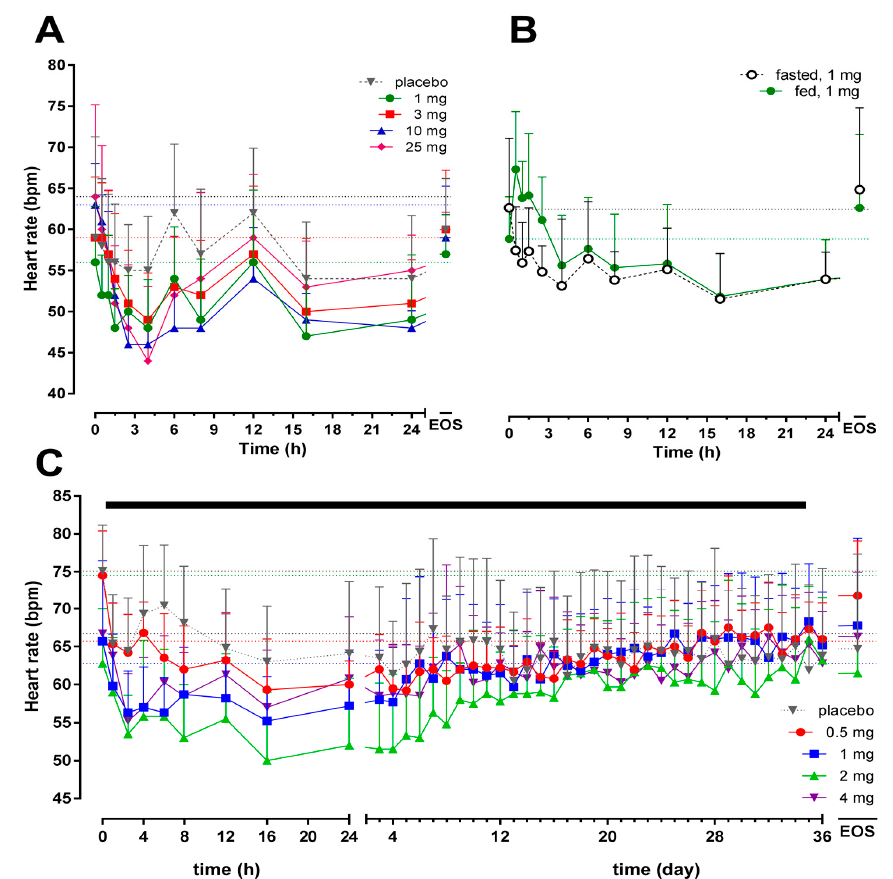
Figure 4. Arithmetic mean (with standard deviation) heart rate versus time profiles from 0 h to EOS after single-dose administration of cenerimod (Panel ( A ), N = 6 per dose group, N = 8 for placebo group), single-dose administration in fed or fasted conditions (Panel ( B ), N = 8), and after multiple o.d. oral doses for 35 days (Panel ( C ), N = 6 per dose group, N = 8 for placebo group). The black bar represents the treatment duration, left part effect over 24 h and right part over 36 days until EOS. The horizontal dotted lines represent the baseline values. EOS: end-of-study.